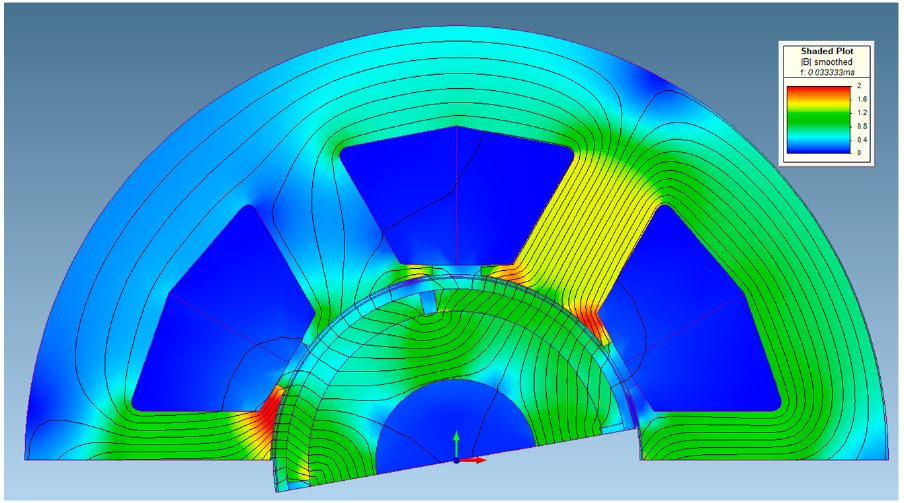
Figure 10. Flux lines and flux density distribution of Mot6 3 with rated current.